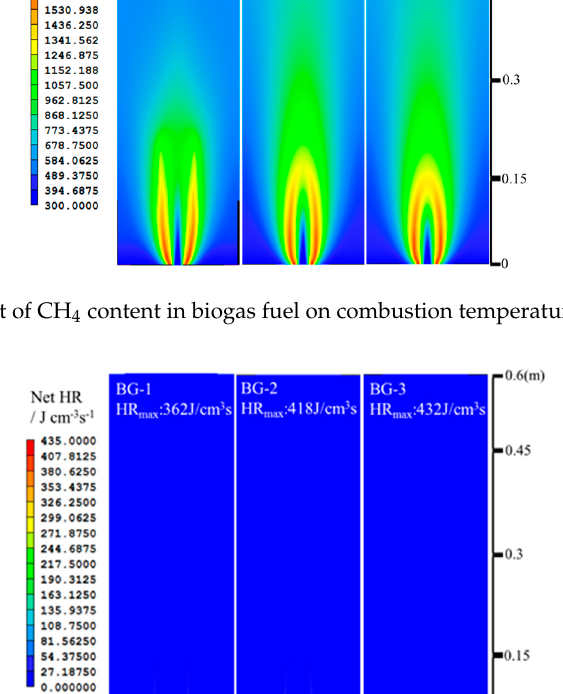
Figure 4. Effect of CH 4 content in biogas fuel on net heat release rate distribution.